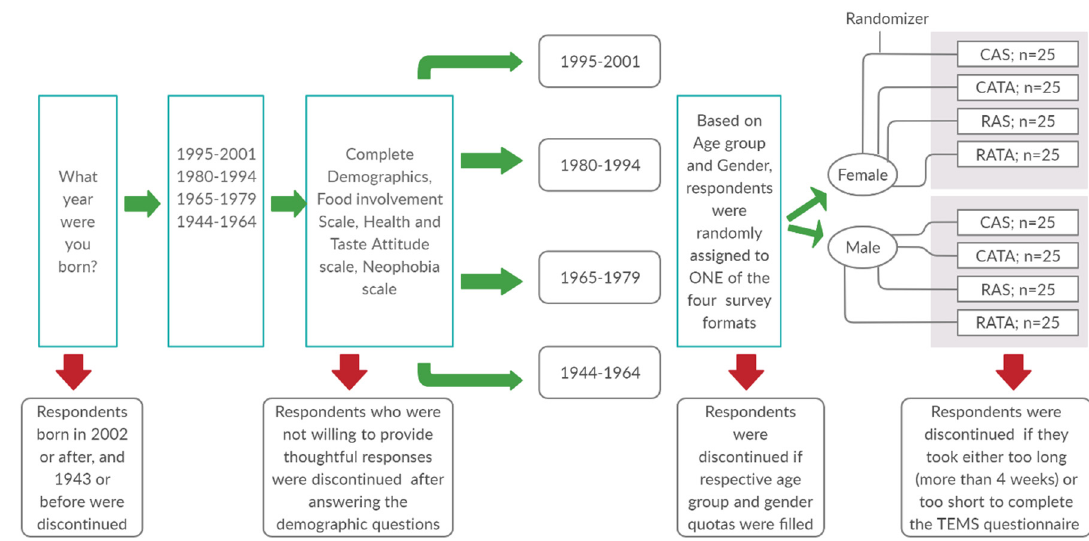
Figure 1. Process flowchart of the recruitment process for respondents who completed the entire survey questionnaire. Green arrows represent respondents who were selected to continue to complete the survey while the Red arrows represent respondents who were discontinued from participating in the survey. A total of 200 respondents per country per question format were recruited.